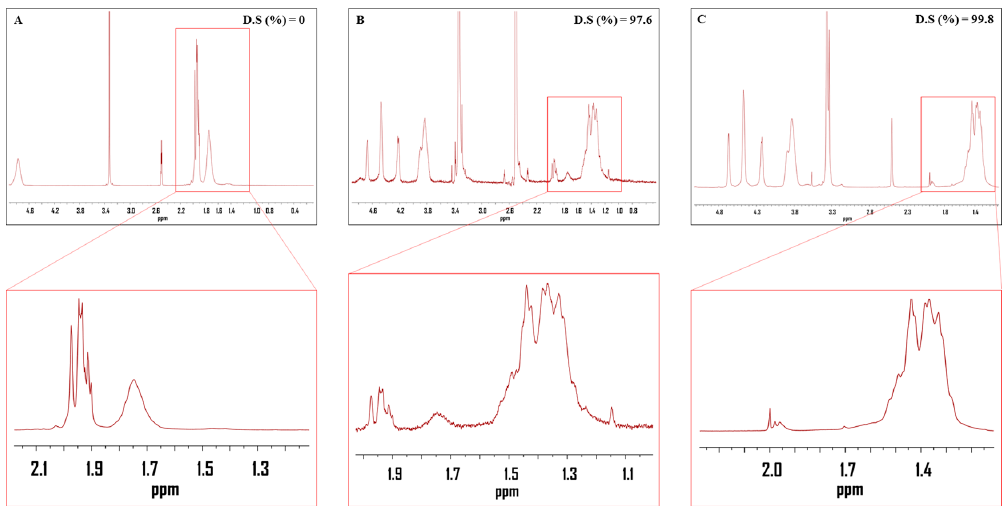
Figure 2. 1 H NMR spectra of the ( A ) PVAc film; ( B ) saponified PVAc film and ( C ) PVA film. The saponification time and temperature were 96 h and 50 °C, respectively. The saponification conditions were 10 g of NaOH, 10 g of Na 2 SO 4 , 10 g of MeOH, and 100 g of H 2 O, and the concentration of PVAc was 10 wt %.